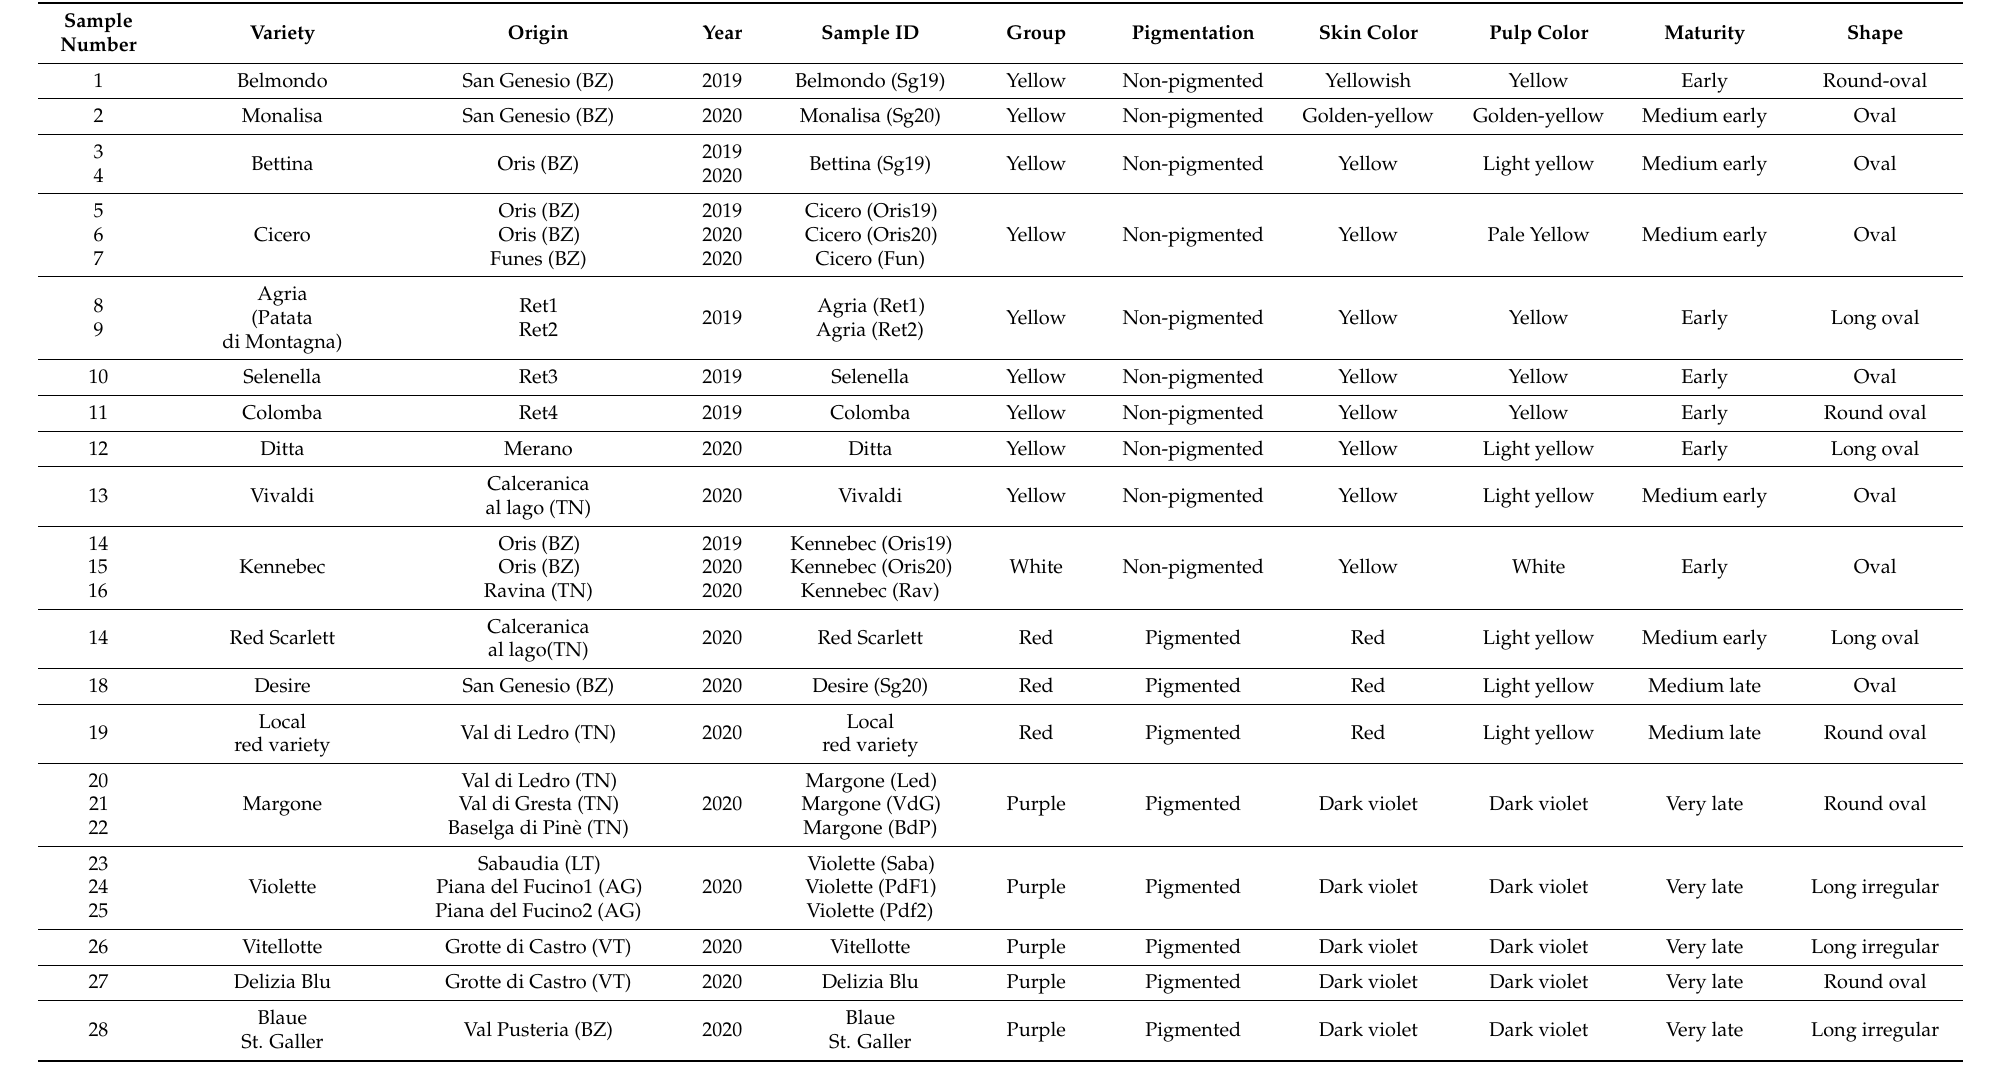
Table 1. List of cultivars used in this study. The potato varieties are ordered by the group. The “sample ID” gathers the abbreviations used in the Figures